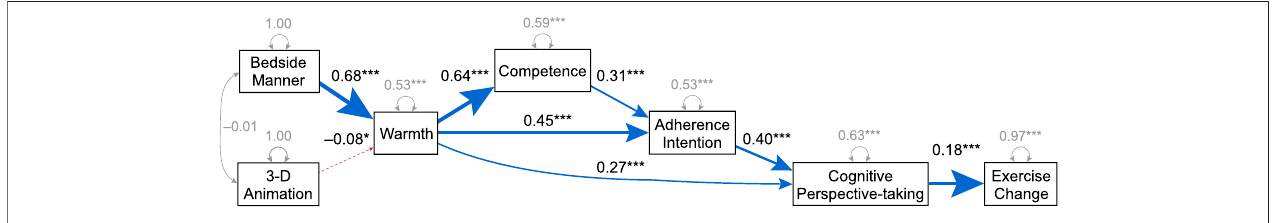
FIGURE 6 | Model 4: Path model of Exercise Change with SCM variables. The blue arrow indicates a positive direct effect, and the red arrow indicates a negative directeffect.Nexttoeacharrow,thestandardizedestimateoftheparameter( β , γ , ζ , φ , ψ )indicatesthestrengthofthedirecteffect,andthenumberofasterisksindicates its signi fi cance level: * p ≤ 0.05, ** p ≤ 0.01, and *** p ≤ 0.001. The independent variables bedside manner (good or poor) and 3-D animation (two levels: either bigeye, swapped, and animation or cartoon and real) are the exogenous variables. The model had acceptable local and global fi t ( Table 4 ).